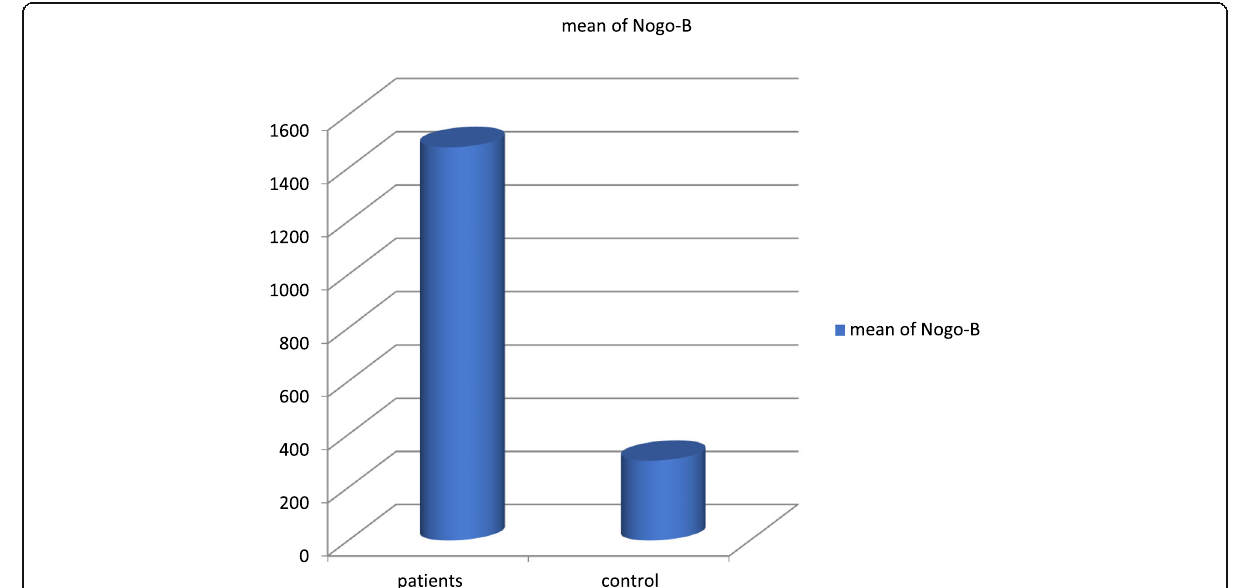
Fig. 1 Comparison between the control group and patients as regards serum level of Nogo-B